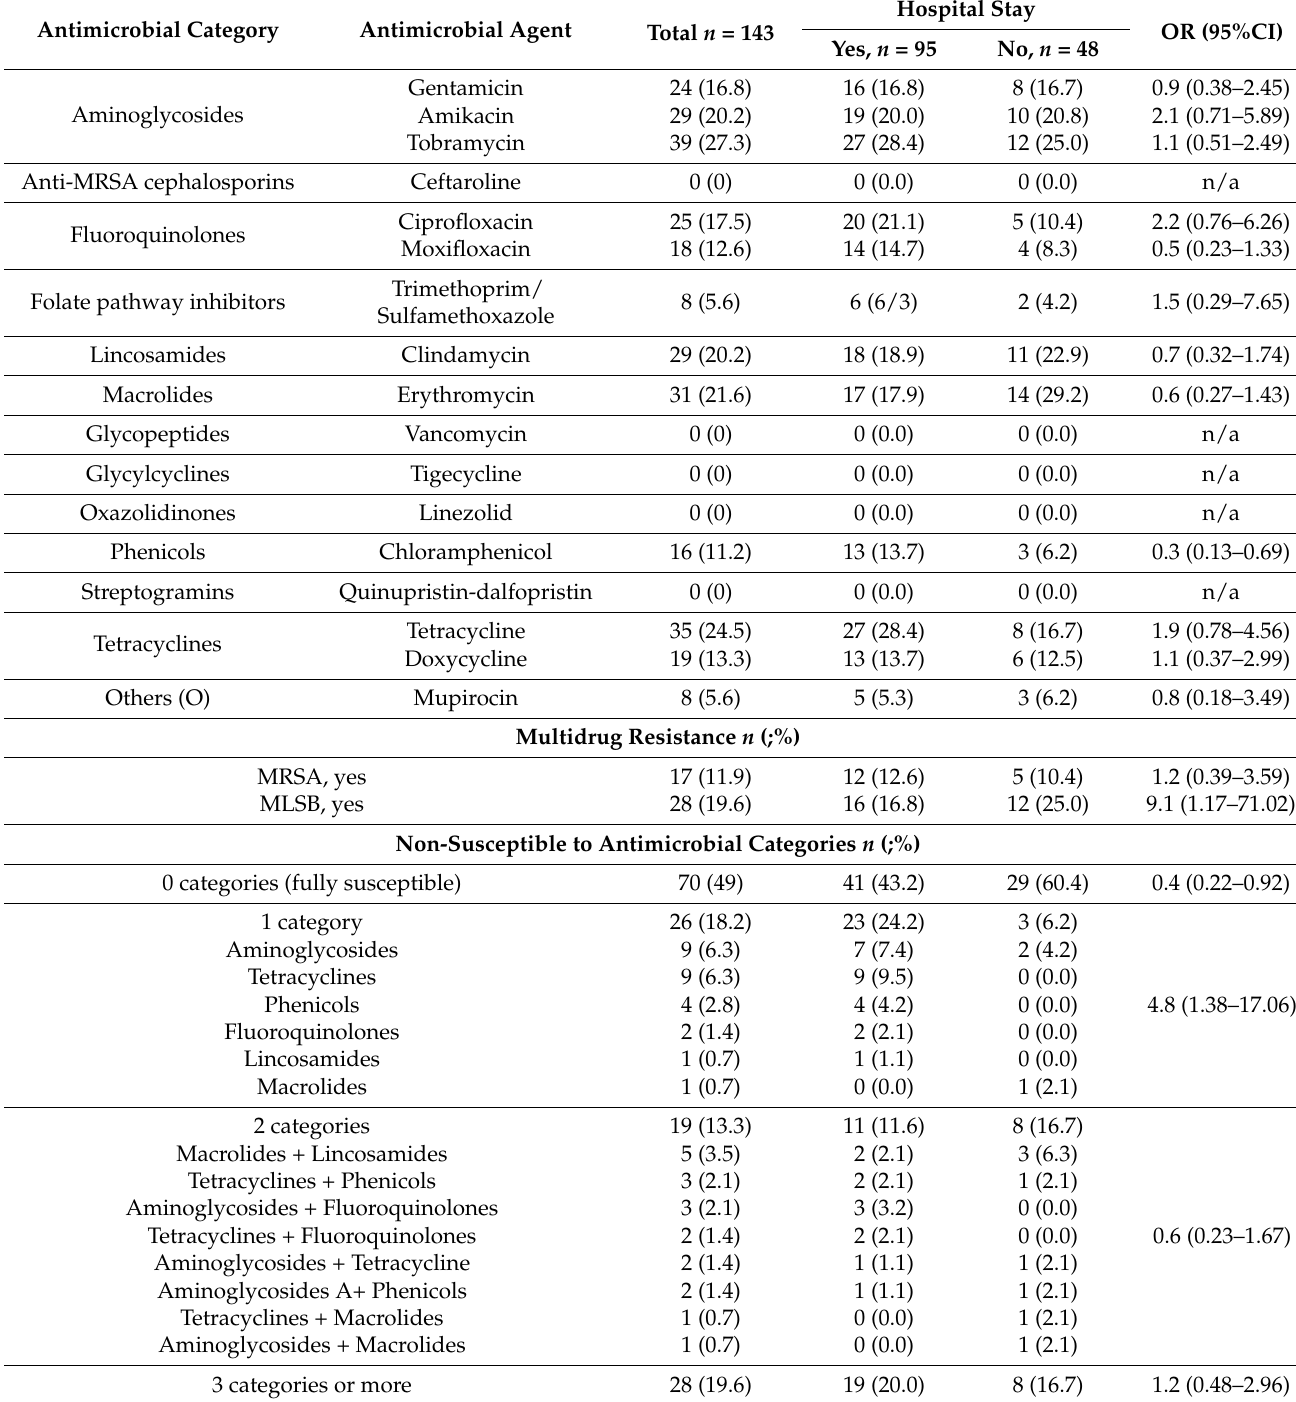
Table 3. Drug-resistance of Staphylococcus aureus isolated from hospitalised and non-hospitalised patients. Antimicrobial